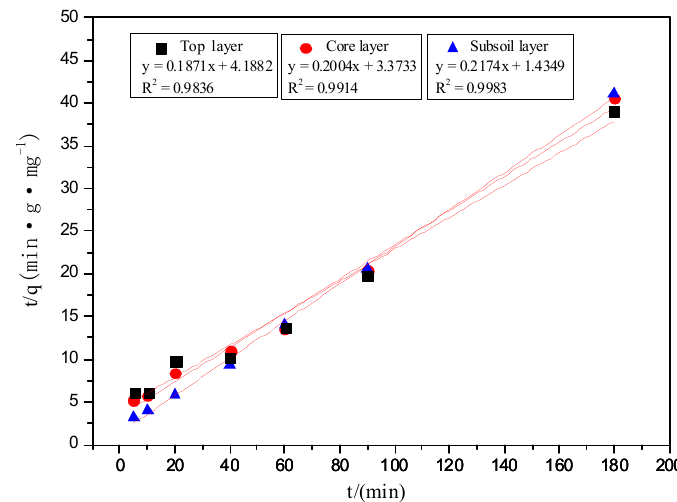
Figure 4. Second-order kinetic equation fitting curve.